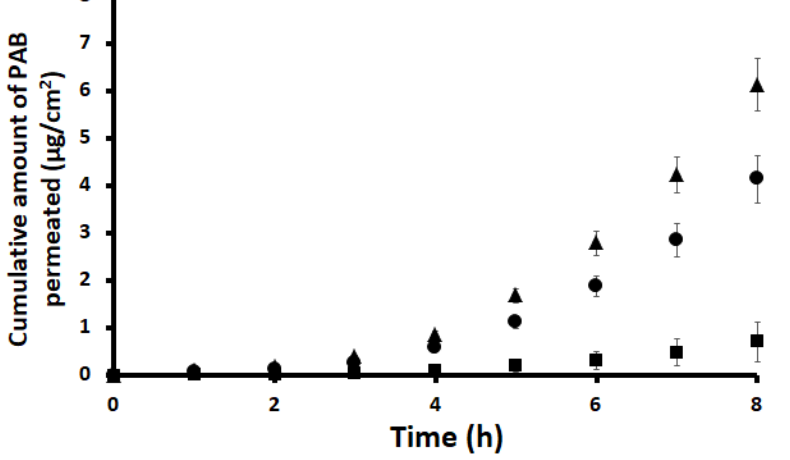
Figure 4. The effect of PEG-GMO formulations on the cumulative amount of PAB over time. ( ■ ), PEG alone; ( • ), PEG-GMO10 formulation; ( (cid:78) ), PEG-GMO20 formulation. Each point represents the PEG alone; (●), PEG -GMO10 formulation; ( ▲ ), PEG-GMO20 formulation. Each point represents the mean ± S.E. of three mean ± S.E. of three experiments.